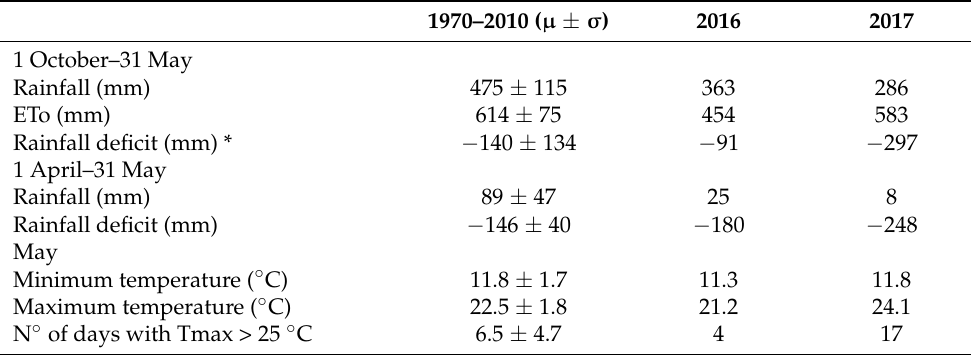
Table 2. Main meteorological data for the two years and as long-term